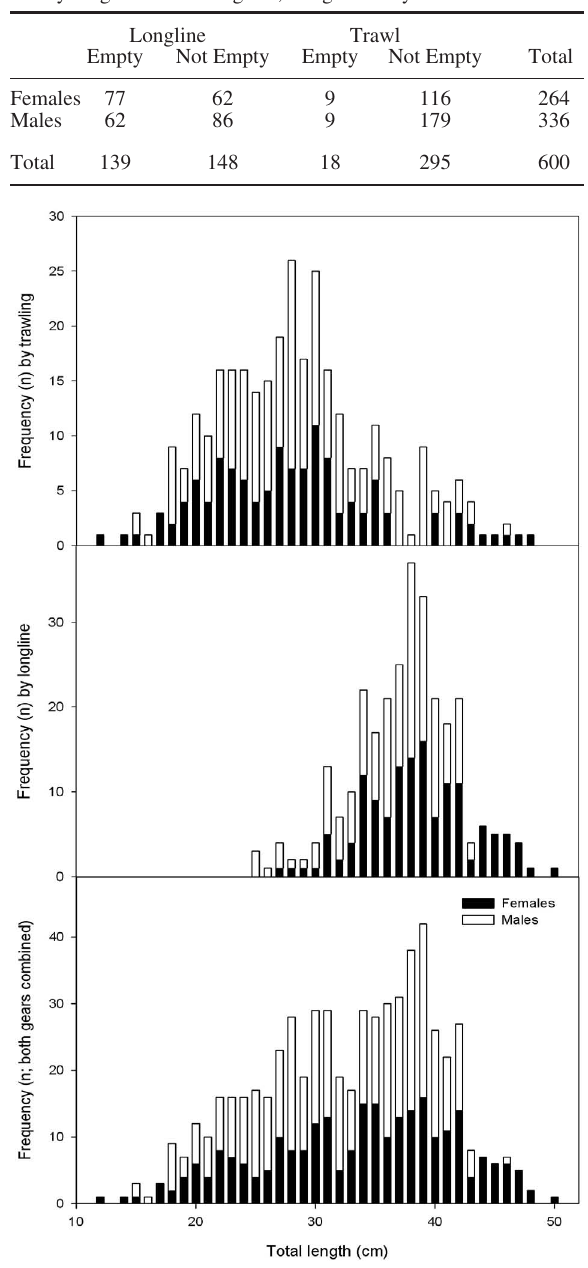
Table 1. – Number of male and female Etmopterus pusillus caught by longline and trawl gears, categorized by stomach status.